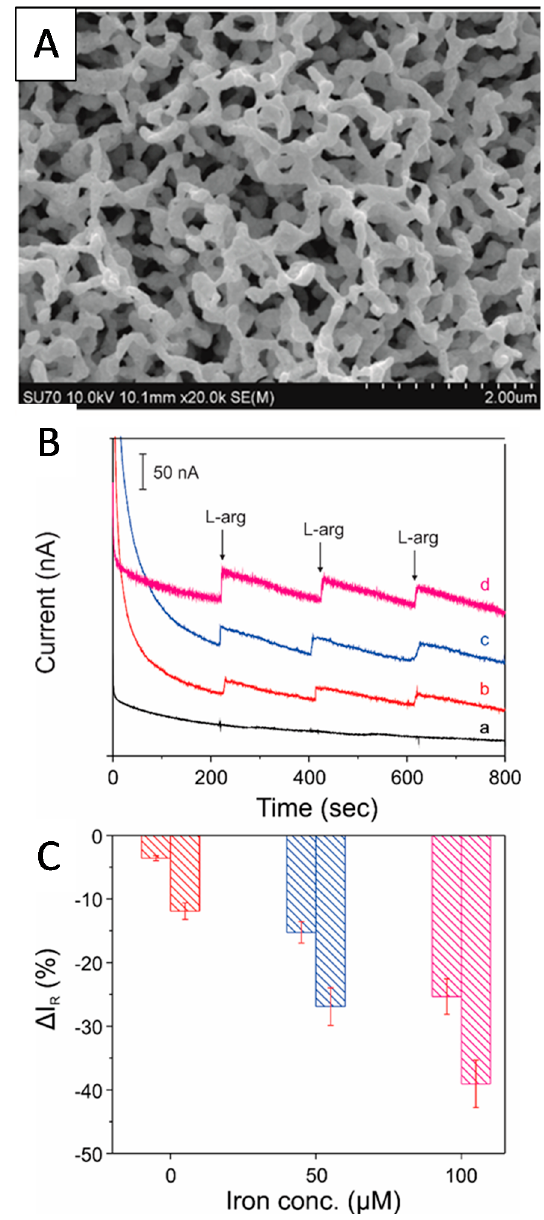
Figure 8. ( A ) SEM images of the hierarchical nanoporous gold (HNG) microwire treated by electrochemical alloying/dealloying in a mixed electrolyte of benzyl alcohol (BA) and ZnCl 2 . ( B ) Amperometric responses to nitric oxide (NO) released from cardiac cells with the successive addition of L -arginine in a 0.1 M of PBS solution (a), containing cultured cells (b), or cultured cells treated with 50 µM of iron (c) or 100 µM of iron (d). Applied potential: 0.80 V. ( C ) The decreased percentage of the responses of NO in comparison with that obtained following the first injection of L -arginine, respectively [89]. Copyright 2017, American Chemical Society.